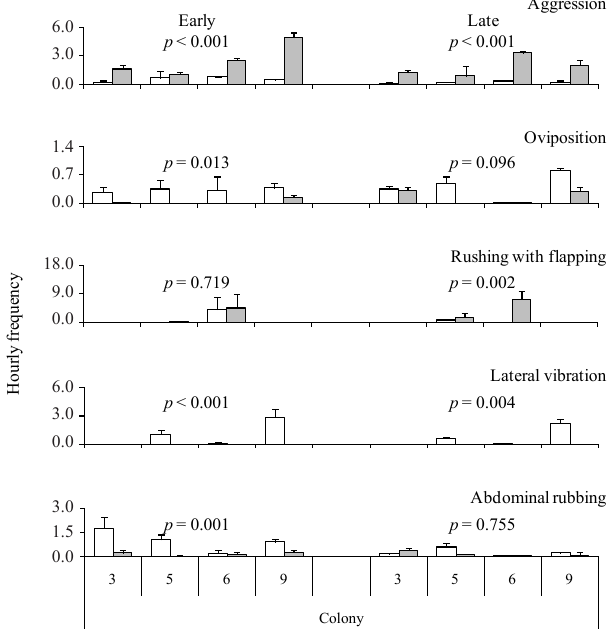
Fig 1. Comparison of the frequencies of five kinds of behavior between the queen (open) and the worker (gray) that performed the focal behavior most frequently. Comparisons were made separately for the early and late stages of the worker phase. The p values were obtained using the stratified Wilcoxon signed-rank test, and those for comparisons between the early and late stages for each behavior performed by the queen (q) and the worker (w) were as follows: aggression, 0.057 (q) and 0.063 (w); ovipositing, 0.114 (q) and 0.004(w); rushing with flapping, 0.170 (q) and 0.504 (w); lateral vibration, 0.418 (q); and abdominal rubbing, <0.001 (q) and 0.972 (w) (exact permutation